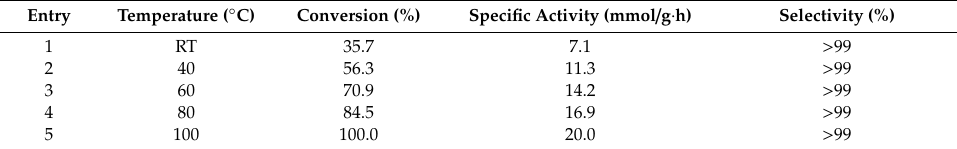
Table 3. Reaction temperature optimization.